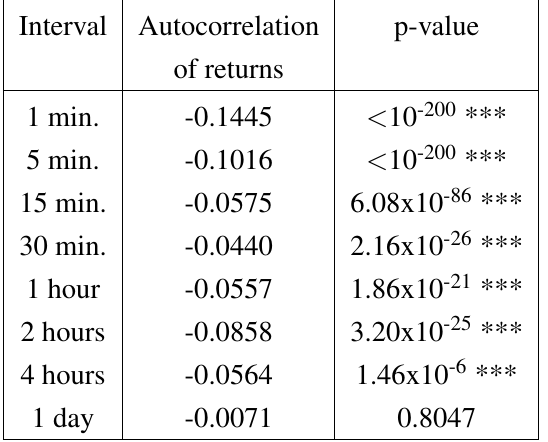
Table 3. First order autocorrelation coefficients at different